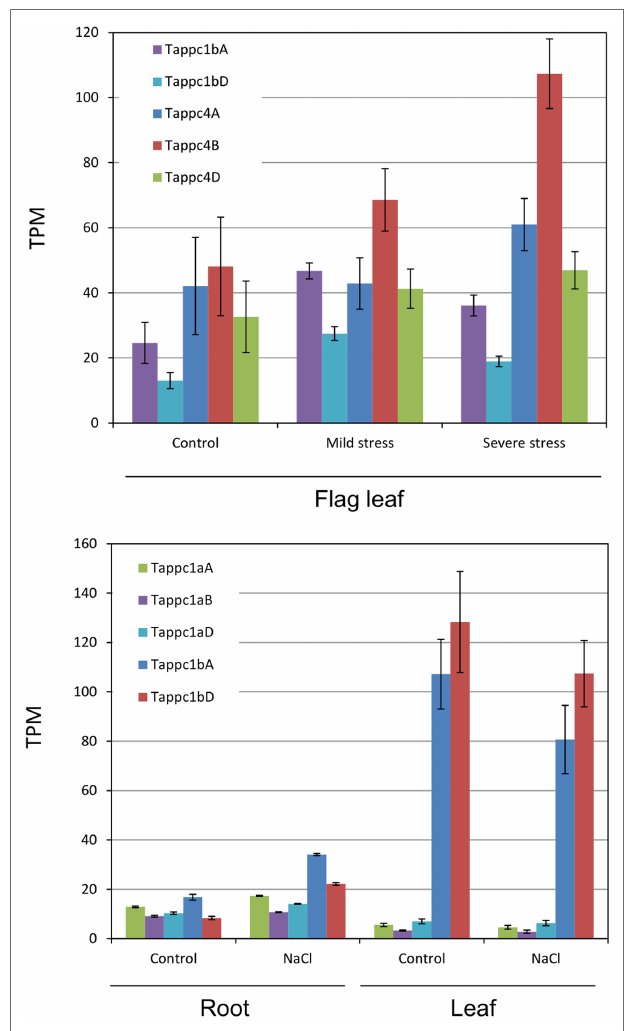
FIGURE 8 | Abiotic stress responses of Tappc1a , Tappc1b , and Tappc4 isogenes. Asterisks represent statistical significance at 5% level in